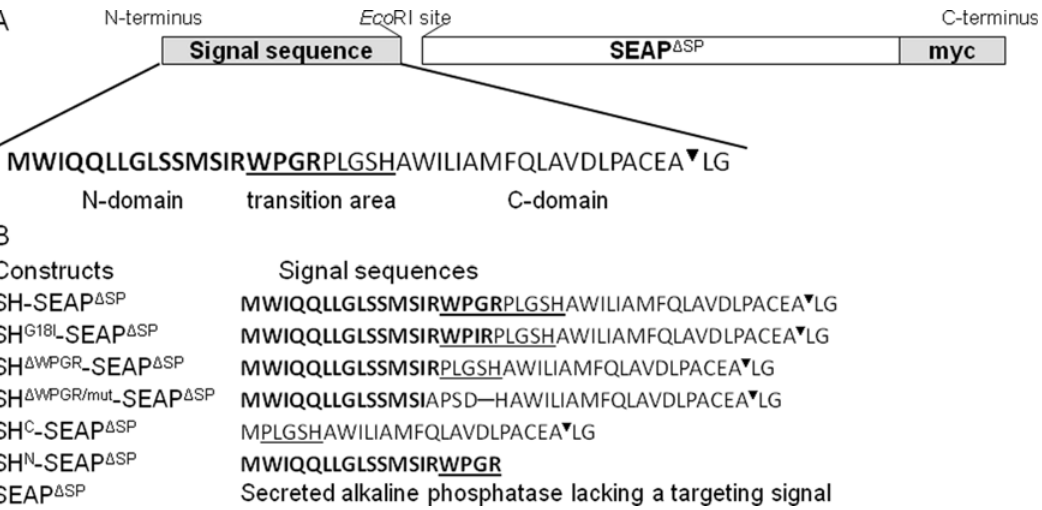
Figure 2. Shrew-1 (SH) signal sequence and the construction of the SEAP fusion proteins. (A) Organization of shrew-1 signal sequence. Bold: N-domain (shrew-1 residues 1–19). Standard type: C-domain (shrew-1 residues 20–43). Underlined: transition area (shrew-1 residues 16–24). . : signal sequence cleavage site. LG: shrew-1 residues 44 and 45. (B) Diagrams of SEAP constructs with assigned shrew-1 signal sequences. Signal sequences are N-terminally fused to the SEAP protein lacking the endogenous signal peptide (SEAP D SP ). C-terminally, all fusion proteins are tagged with myc (EQKLISEEDL). For cleavage site recognition (PACEA . LG) shrew-1 residues 44 and 45 (LG) are included in the constructs.